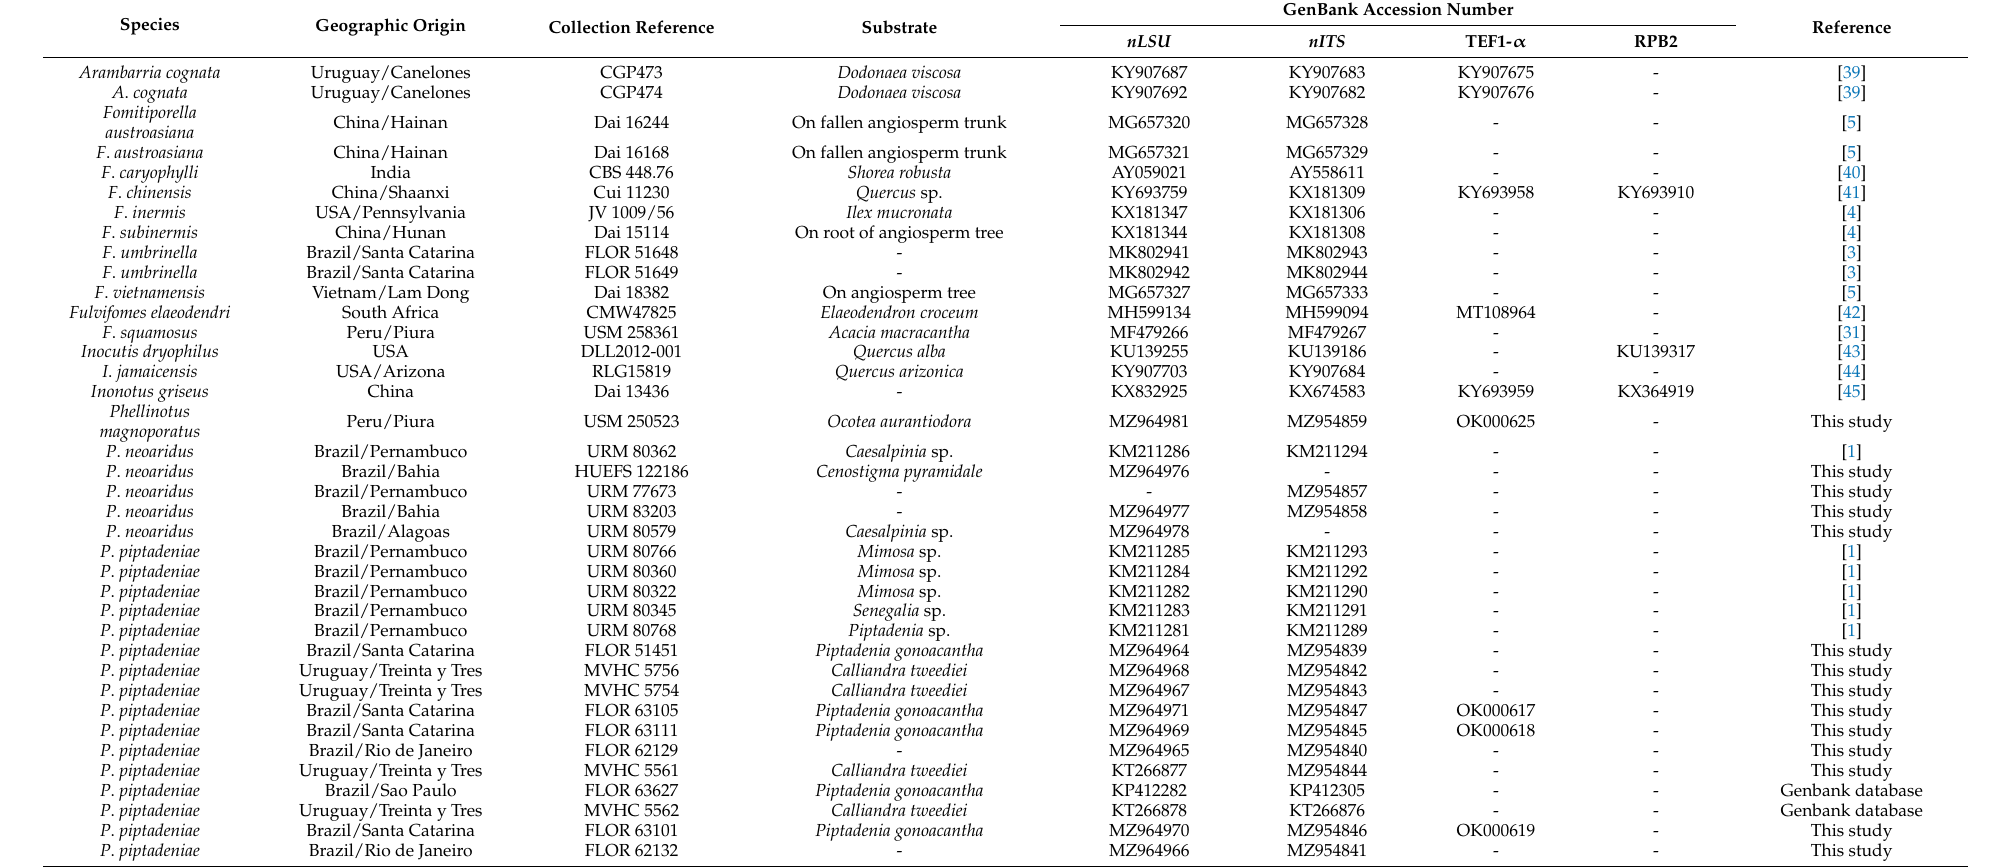
Table 1. List of species, sources, localities, and GenBank accession numbers of taxa used in this